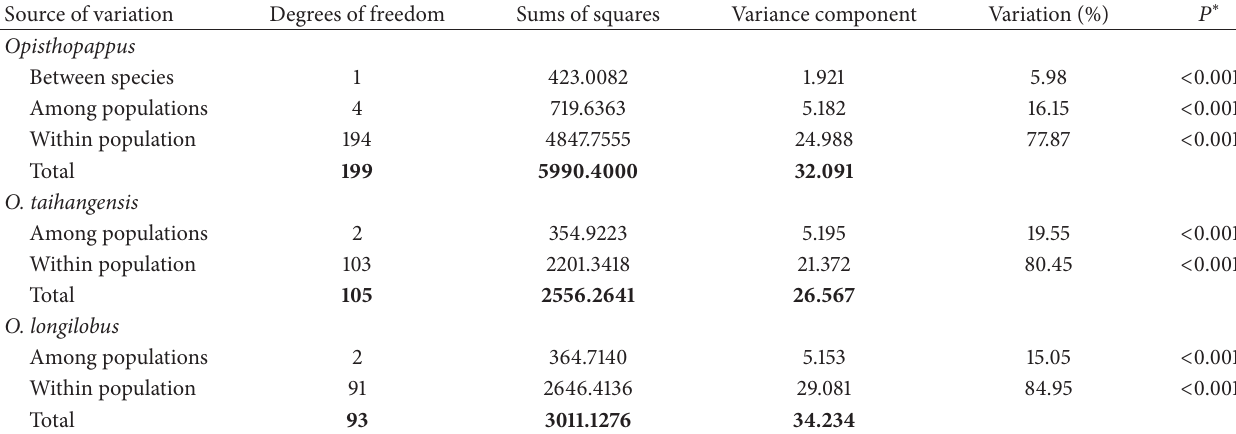
Table 5: The analysis of molecular variance (AMOVA) in Opisthopappus.